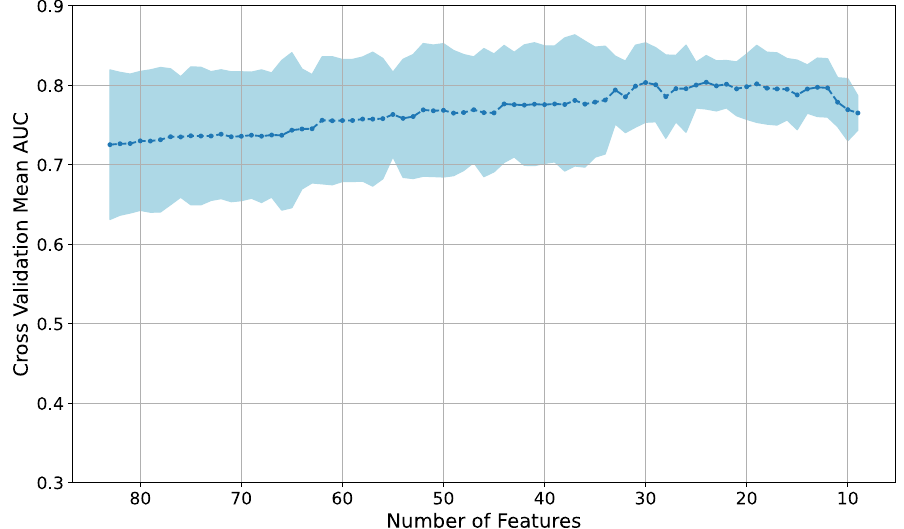
Fig. 2 Cross-validation area under the receiver-operator characteristic curve (AUROC) vs. number of features. AUROC area under the receiver operator characteristic